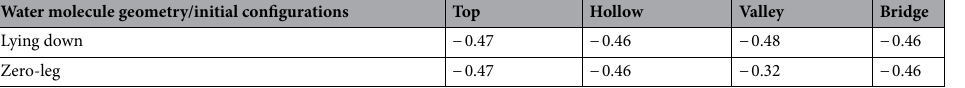
Water molecule geometry/initial